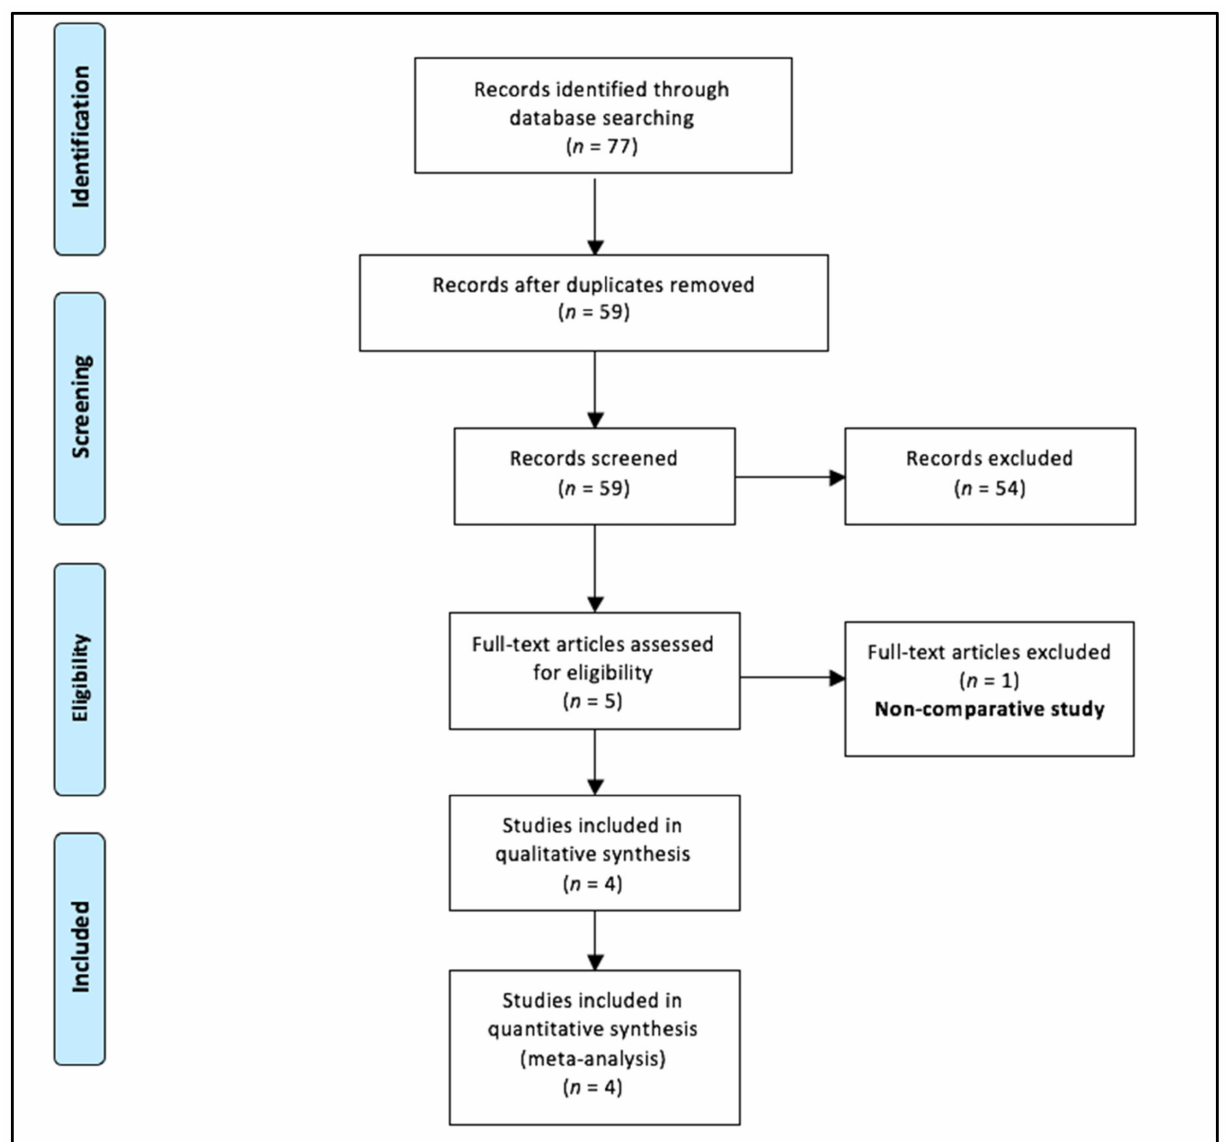
Figure 1. Selection of the relevant studies using the Preferred Reporting Items for Systematic Review and Meta-Analysis (PRISMA) flow